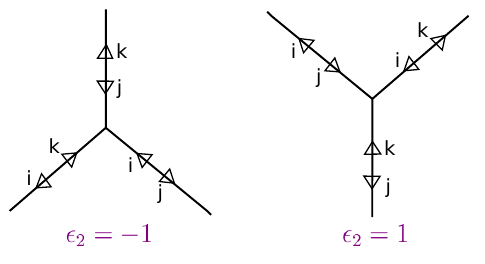
Figure 23 . The two types of trivalent vertices and their corresponding (cid:15) 2 .